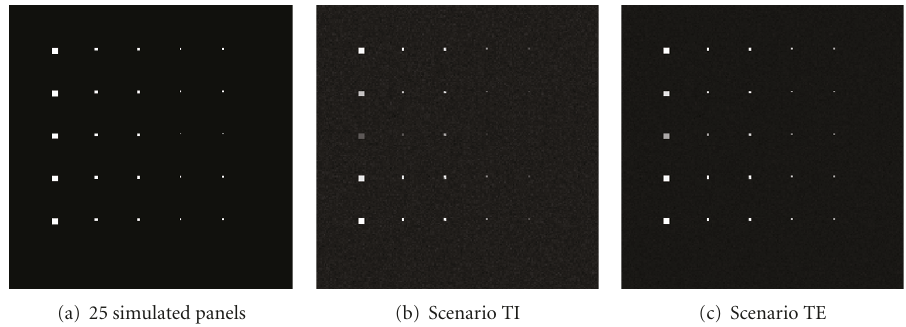
Figure 3: 25 simulated panels according to Tables 1 and 2 and two scenarios for target insertion, TI and